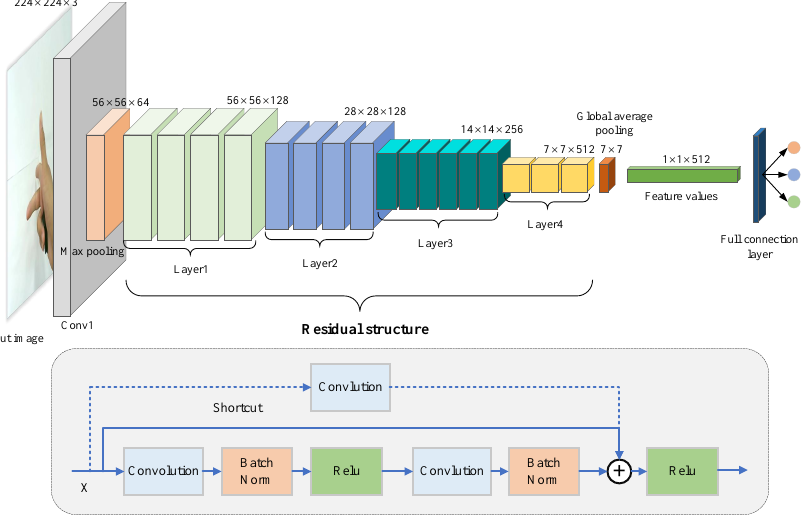
Figure 4. The ResNet34 structure